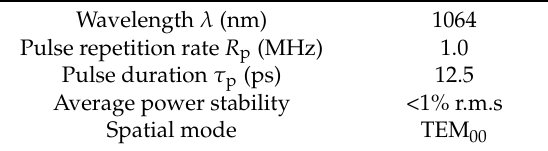
Table 2. Specifications of laser oscillator. Figure 3. Schematic illustration of observation direction by optical microscope.